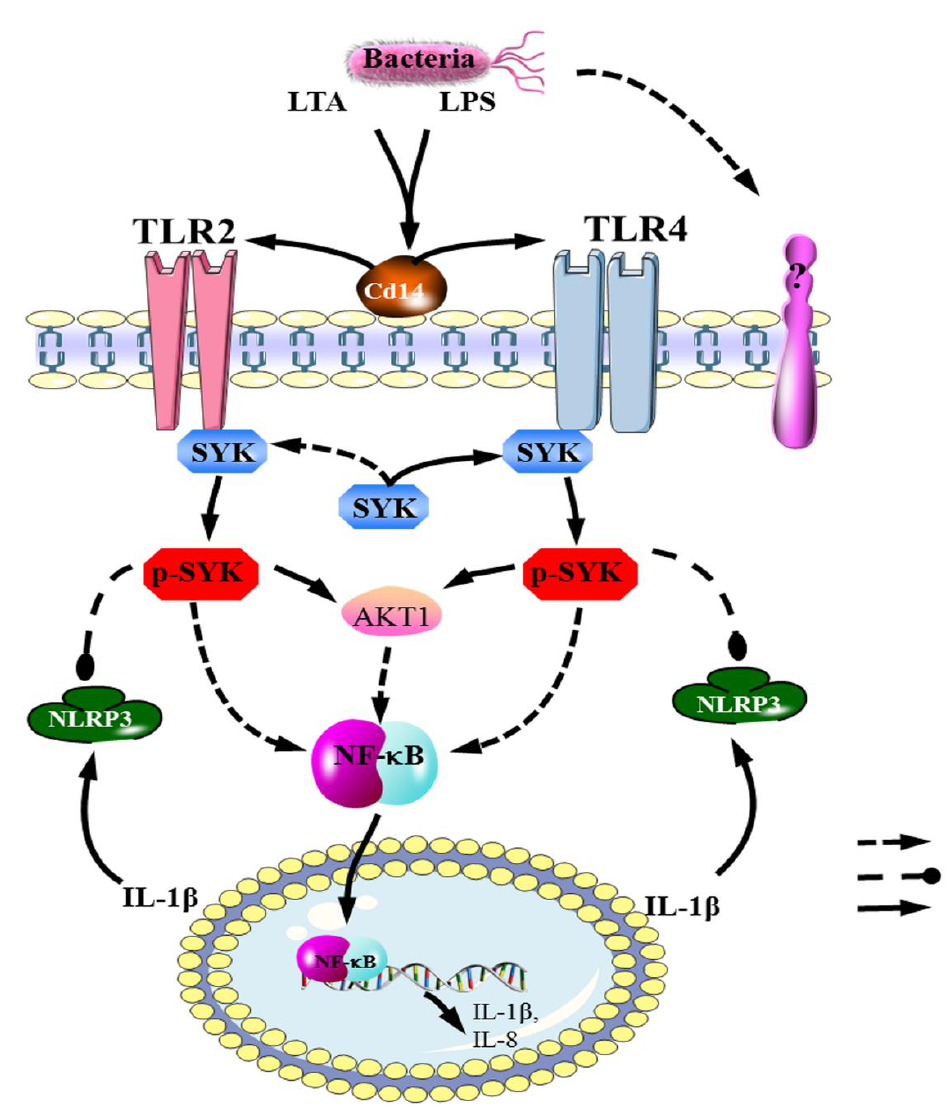
Figure 8. The TLR4 – SYK signal axis exists in bMECs with LPS or